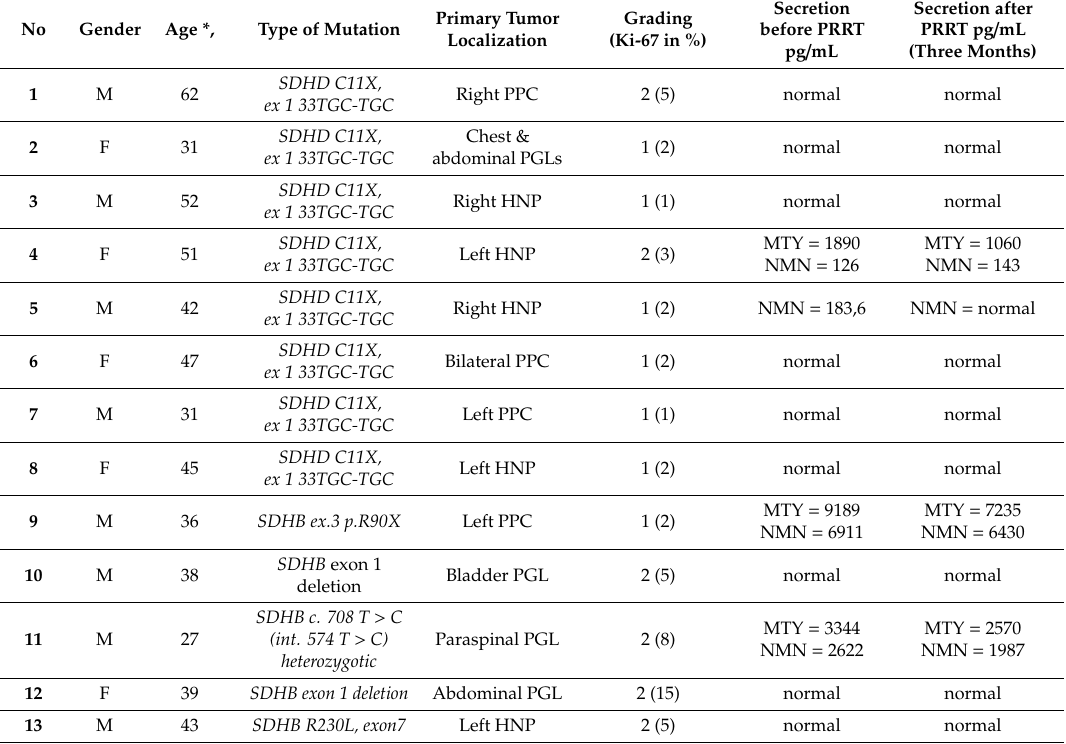
Table 2. Details of genetic mutation in all patients, primary tumor localization, grading (G) of tumor di ff erentiation and mitotic index, as Ki-67, using MIB1 antibody. Additional secretion before PRRT and three months after